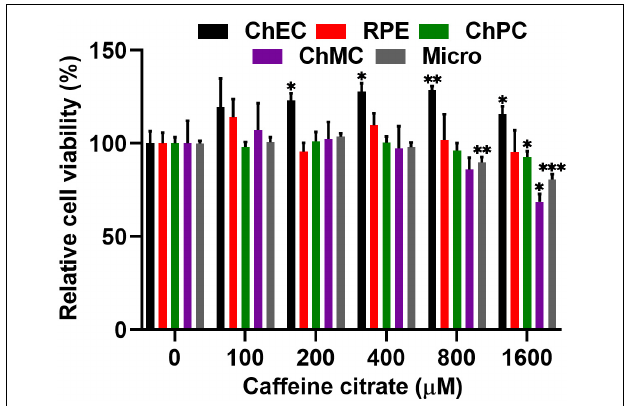
FIGURE 2 | Minimal toxicity was noted in ocular cells incubated with different concentrations of caffeine. Cell viability relative to control cells, was assessed after 48 h of incubation with different concentrations of caffeine as detailed in Methods. Each experiment was done in triplicate and repeated with at least two different isolation of the desired cells (* p < 0.05, ** p < 0.01, *** p <